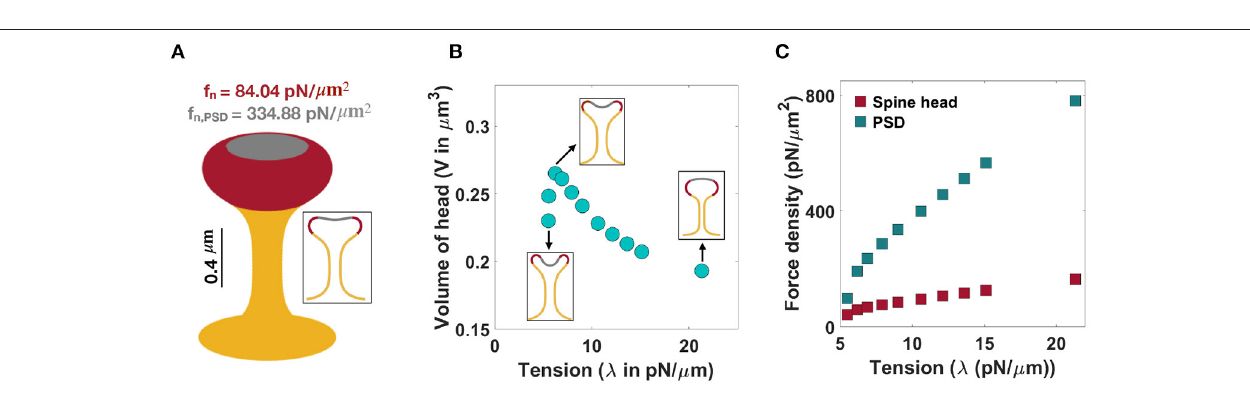
FIGURE 4 | Formation of mushroom-shaped spines with localized normal forces along the spine head and PSD. (A) A mushroom-shaped spine with a total length L 1.51 µ m, neck radius r 0.1 µ m, head volume V 0.25 µ m 3 , and area of PSD/area of head 0.2 is formed with f n 84.04 pN /µ m 2 applied along the head of = = = = = spine (red domain) and f n,PSD 334.88 pN /µ m 2 applied along the PSD (gray domain) ( λ = 9 pN /µ m). (B) The non-monotonic behavior of the volume of a = mushroom-shaped spine head when increasing tension. Three different shapes of mushroom-shaped spines are shown for low, intermediate, and high tensions. With